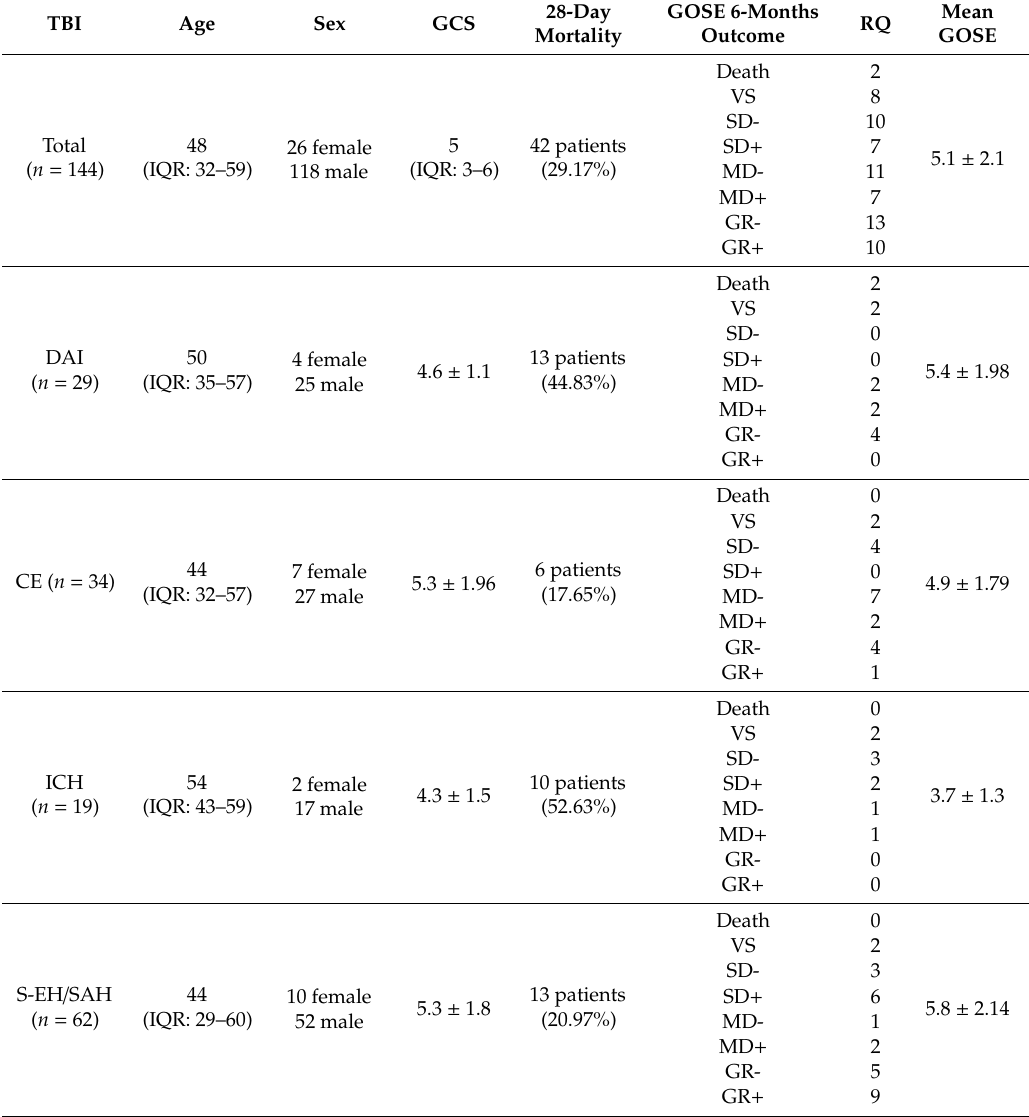
Table 2. Demographic